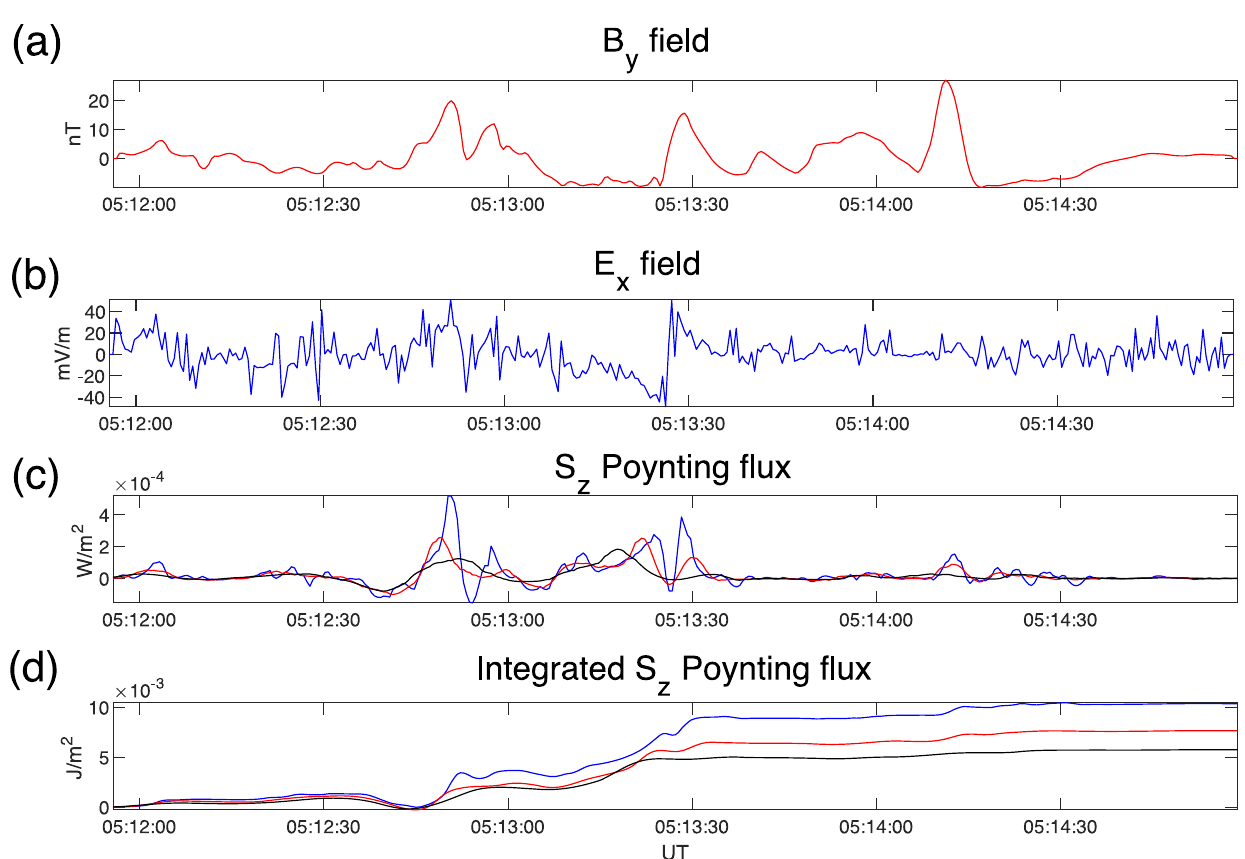
Fig. 4 Example event selection during a Swarm A auroral zone crossing. Magnetic and electric fi eld and related fi eld-aligned electromagnetic energy from an event selected by the analysis algorithm between 05:12:00 and 05:15:00 UT on 17 November 2016. Panels show a magnetic fi eld B_y component, b electric fi eld E_x component, c S_z component Poynting fl ux low-pass fi ltered with S2avitsky-Golay fi lter of window sizes 9, 27 and 47 s (blue, red and black, respectively), capturing small-scale, mesoscale and large-scale perturbations, and d along-track integrated Poynting fl ux using the three fi ltered time series from c . Note that the event is selected based implicitly on coherent electromagnetic fi elds, and with its temporal extent de fi ned from the local peak in the low-pass fi ltered Poynting fl ux to a speci fi ed lower threshold (see text for details). Please note that error estimates on the electric fi eld are not provided in the dataset. Please refer to ref. 36 for a discussion of the